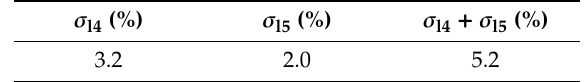
Table 6. Theoretical prestress loss of BFRP tendons during the in-service stage.